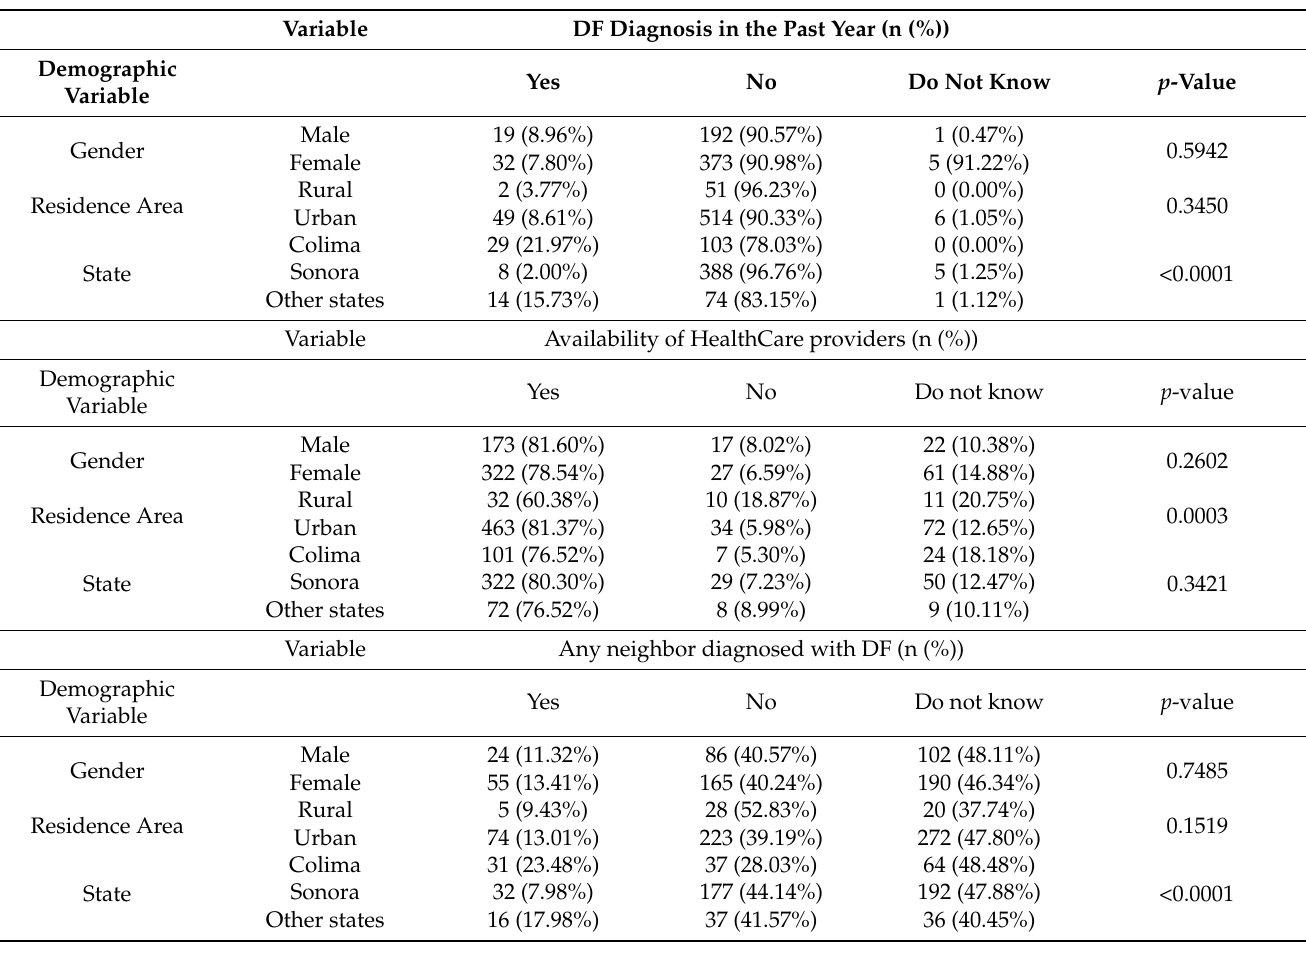
Table 3. Proportions and p -value for different Chi-Squared Test results with 95%